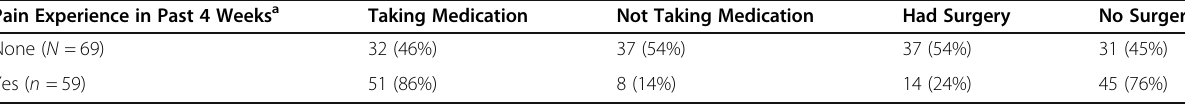
mon of which were cerebrospinal fluid leak, unsteady on